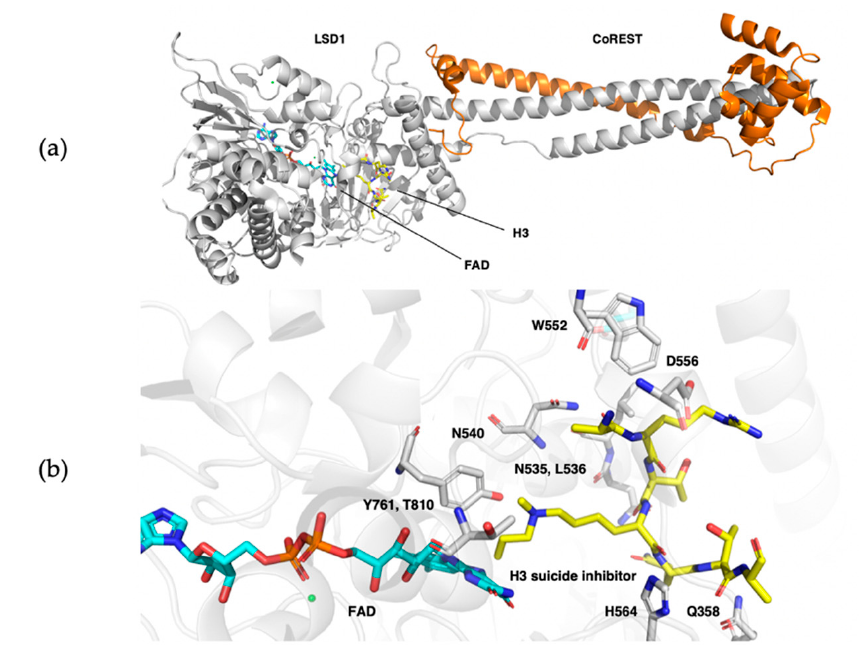
Figure 10. ( a ) Ribbon representation of lysine-specific demethylase 1 (LSD1)–co-repressor of RE1-silencing transcription factor (CoREST) in complex with a flavin adenine dinucleotide (FAD)-H3 suicide inhibitor (PDB-ID: 2UXN). LSD1 (grey), CoREST (orange), FAD (cyan), H3 suicide inhibitor (yellow), Cl- ions (green). ( b ) Key residues of the LSD1-H3-binding domain in complex with a FAD-H3 suicide inhibitor for LSD1 (grey). FAD (cyan), H3 suicide inhibitor (yellow) [103]. Int. J. Mol. Sci. 2020 , 21 , x FOR PEER REVIEW